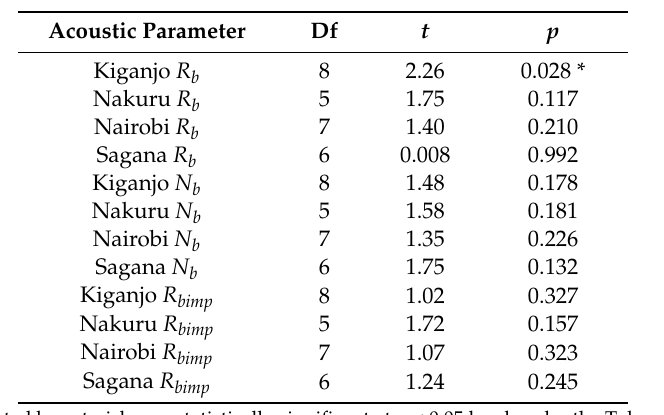
Table 4. Student’s t test comparisons of di ff erences between means of AEC and IMC acoustic parameters at di ff erent